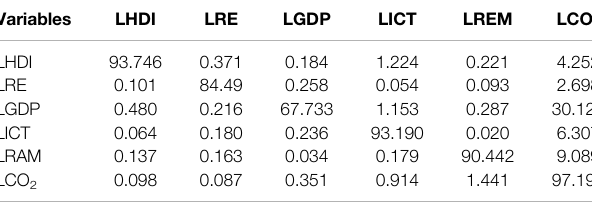
TABLE 6 | Variance decomposition of the PVAR (%). Variables